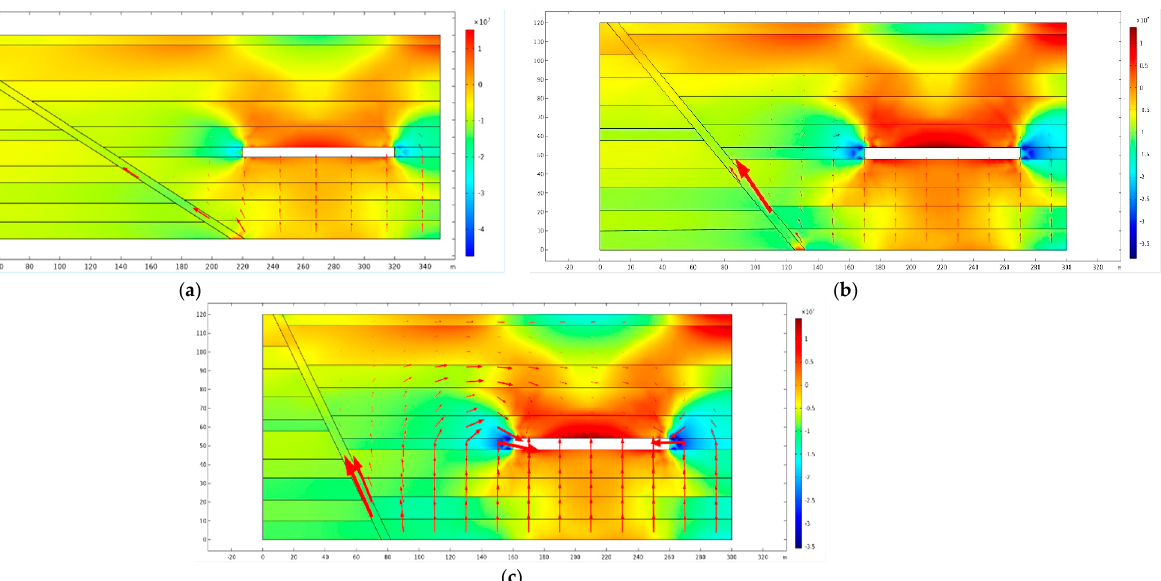
Figure 5. Different fault dip seepage fields. ( a ) 30 ◦ fault dip seepage field. ( b ) 45 ◦ fault dip seepage field. ( c ) 60 ◦ fault dip seepage